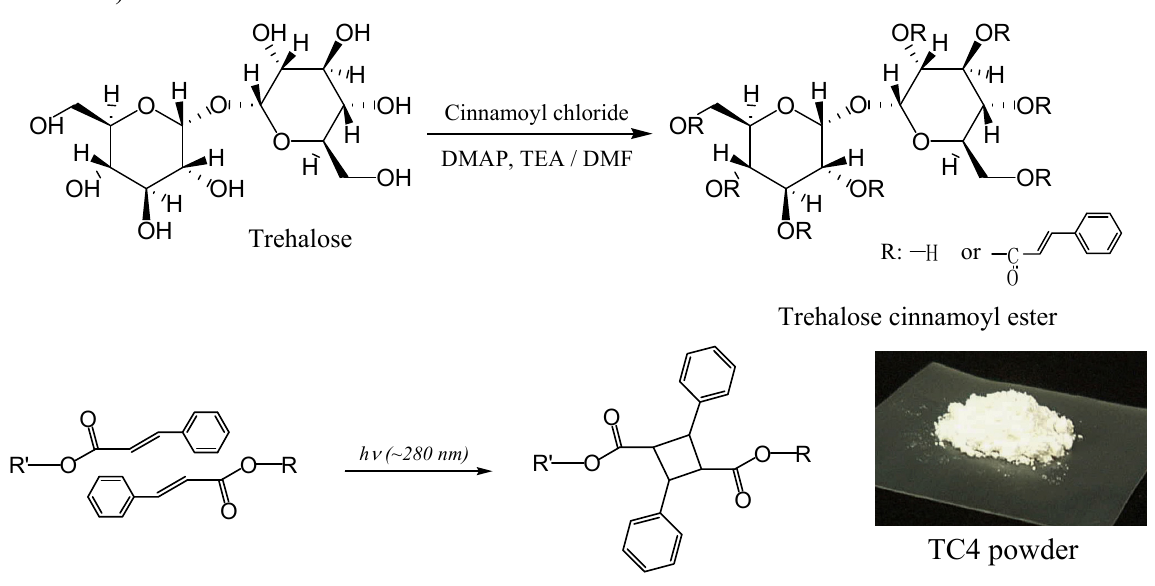
Figure 9. Synthesis of trehalose cinnamoyl esters and [2+2] Cycloaddition reaction of cinnamate groups (reproduced from the reference [224] with the permission of John Wiley & Sons).